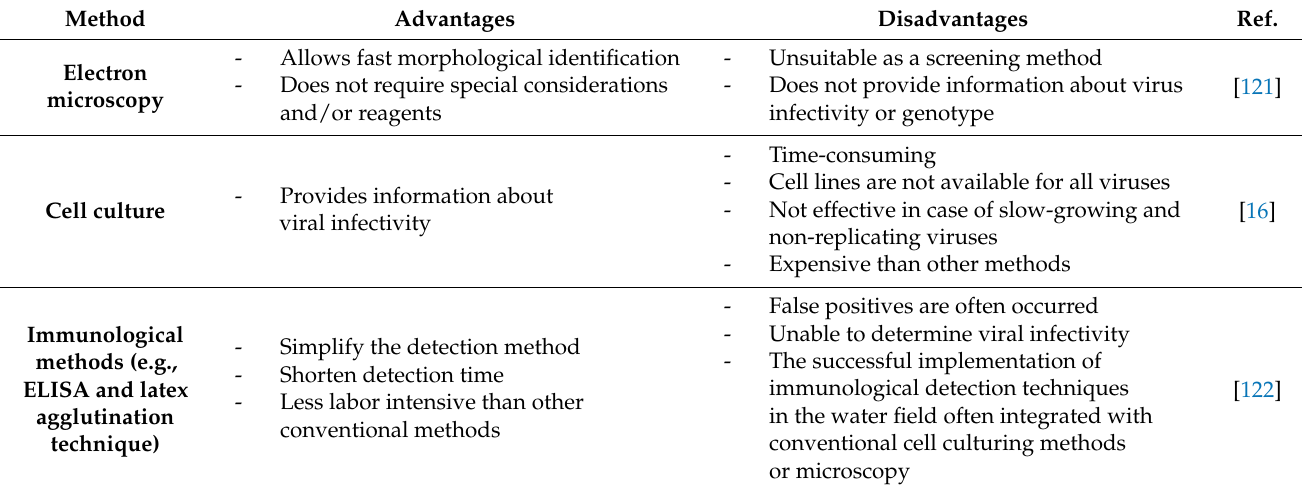
Table 4. Merits and demerits of viral pollution detection